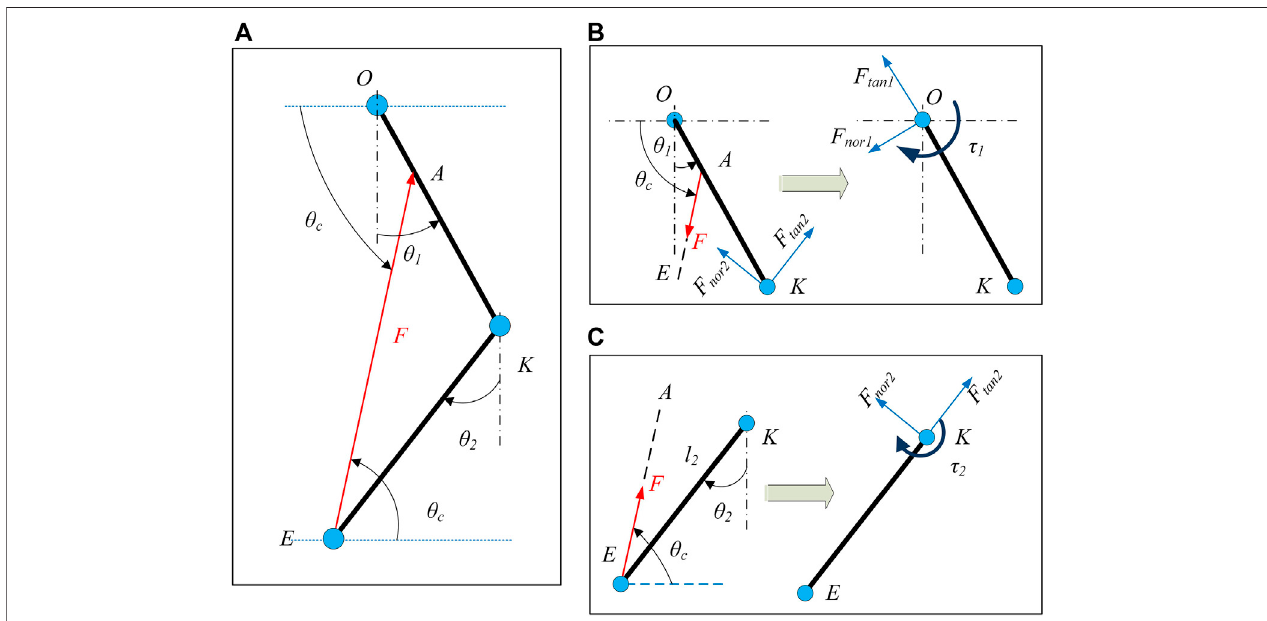
FIGURE 3 | Two link model with applied cable tension (A) , Force to Torque mapping for shank (C) , and Force to Torque mapping for thigh (B) . F tan and F nor represent the compressive and shear forces respectively induced on the joints. Subscripts 1 and 2 represent the hip and knee joints respectively.